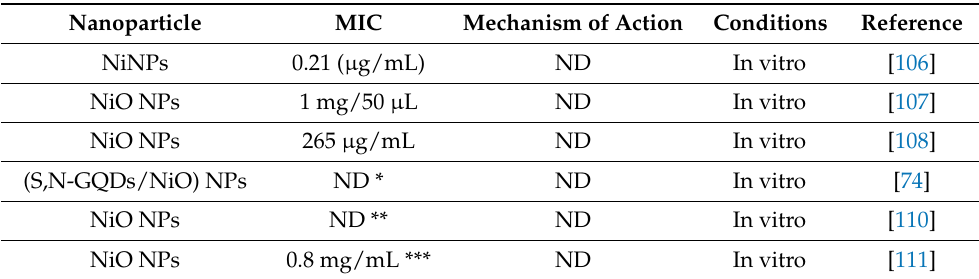
Table 1. NiNP concentrations and conditions against MRSA in vitro.